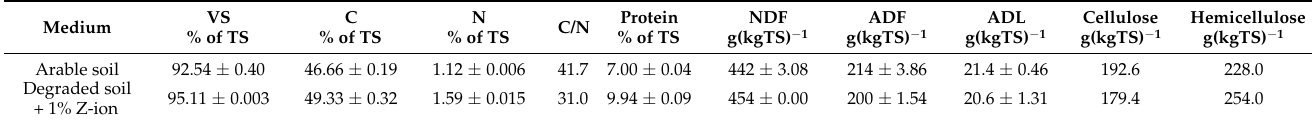
( a ) ( b ) Figure 2. Cumulative biogas production for ( a ) the cocksfoot biomass obtained in arable soil and degraded soil supplemented with a 1% Z-ion addition and ( b ) the maize biomass obtained in arable soil and degraded soil supplemented with a 5% Z-ion addition (values presented as means, n = 3). Table 3. Chemical composition of the cocksfoot biomass used in the batch digestion test.